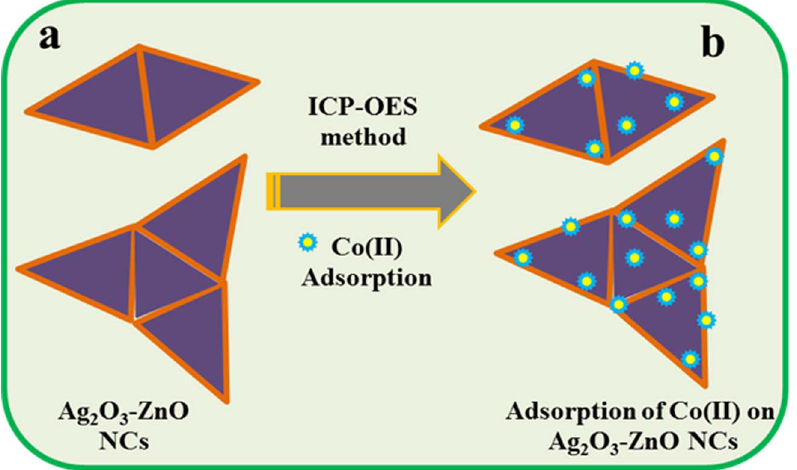
Figure 7. Studied of selective ionic Adsorption. Schematic representation of before (a) and after (b) selective Co(II) adsorption onto doped Ag 2 O 3 -ZnO